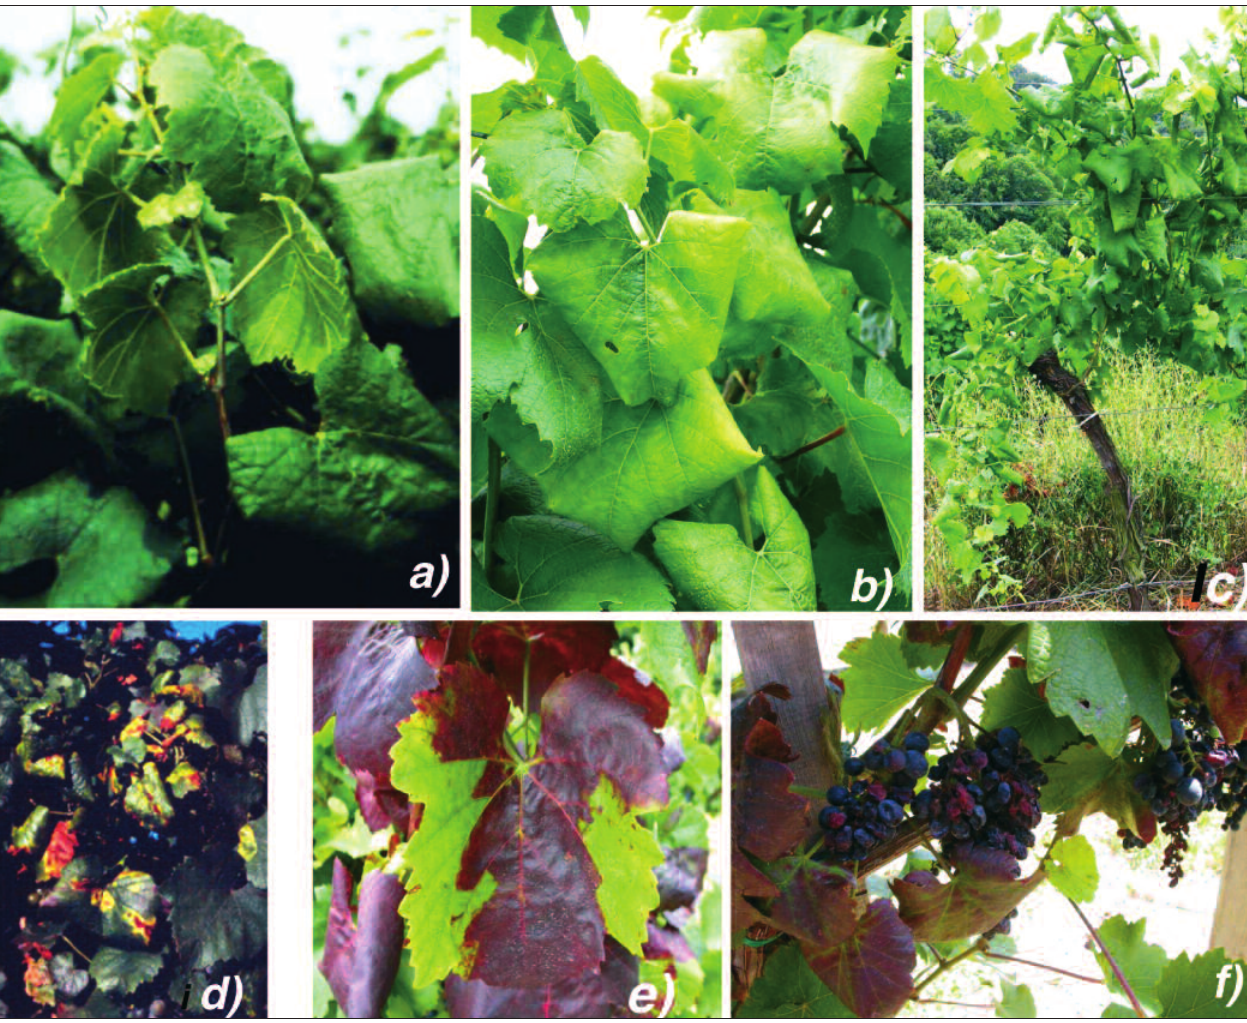
Fig1: Typical symptoms of Grapevine yellows (GY) diseases : a ) First symptoms on young shoot: zig-zag growths and shortened internodes, pale, downward rolling leaves; b) leaf rolling and chlorosis become more evident during vegetation, c) severe, triangle-shape leaf rolling is typical for GY. d) On white varieties the colour of the leaves turn yellow; leaf blades show yellow areas with necrotic tissues; e) on red varieties reddish to purple colours may appear sectorial ( in the centre) or on the entire leaf blade including the veins (left ). f) Berries shrivel and die on the infected